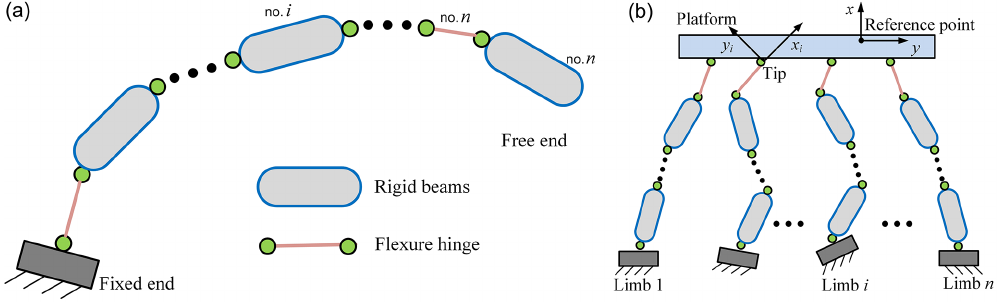
Figure 1. Flexure-based compliant mechanisms: (a) flexure serial structure; (b) flexure parallel